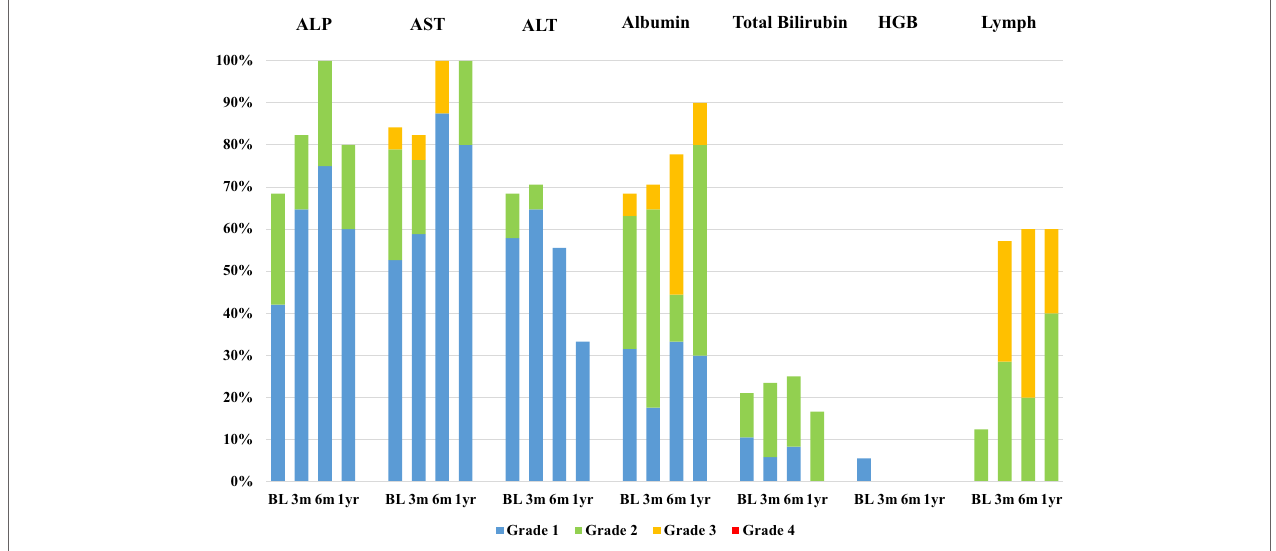
FigUre 1 | Bar chart demonstrating the incidence of laboratory toxicities at baseline visit (Bl) and 3, 6 months, and 1 year after sirT . Laboratory parameters included alkaline phosphatase (ALP), aspartate aminotransferase (AST), alanine aminotransferase (ALT), albumin, total bilirubin, hemoglobin (HGB), and